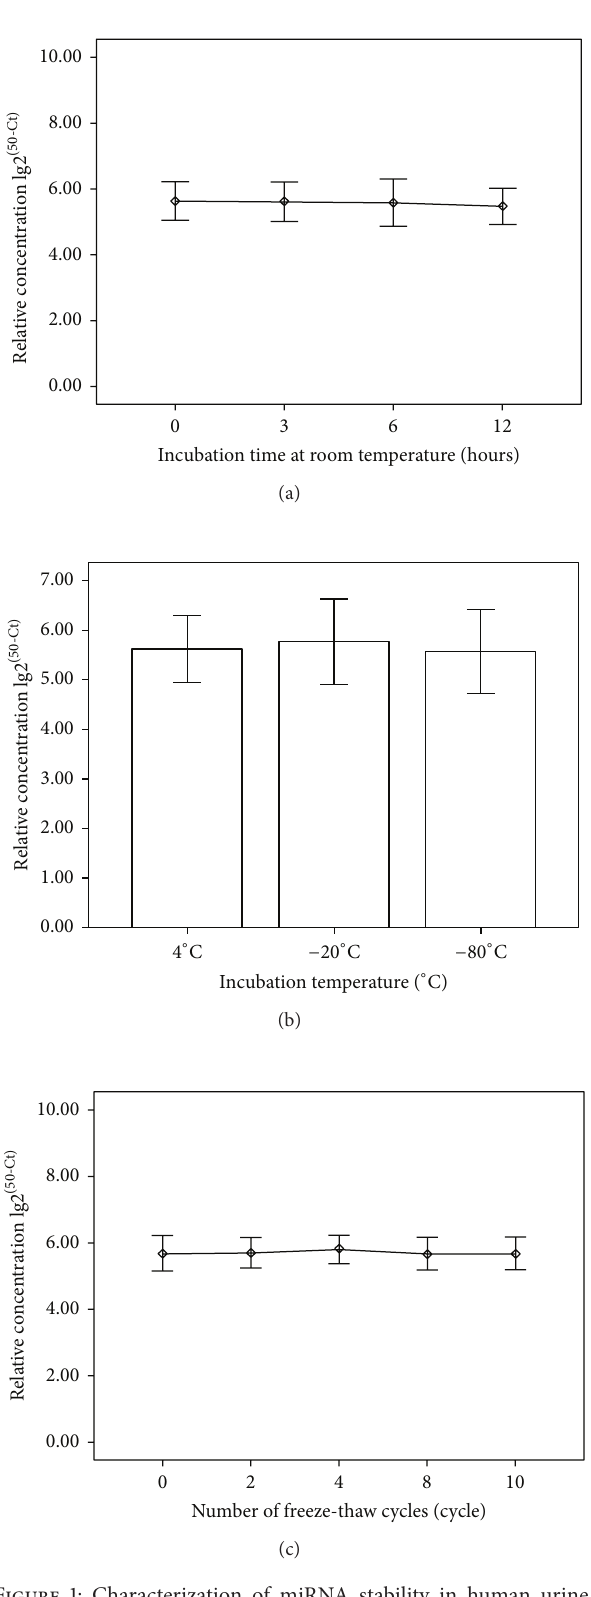
Figure 1: Characterization of miRNA stability in human urine. miRNA levels remain stable when urine is subjected to prolonged room temperature incubation (a), stored at 4 ∘ C, − 20 ∘ C, − 80 ∘ (b), or freeze-thawed up to multiple times (c). The 𝑃 value is 0.161, 0.134, and 0.643, respectively, 𝑛 = 60